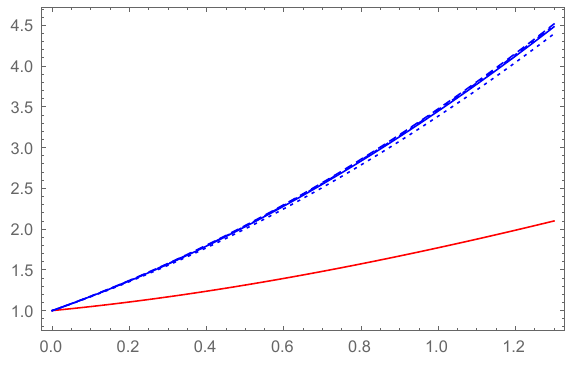
(cid:0) (cid:1) Tg µν − T µν with